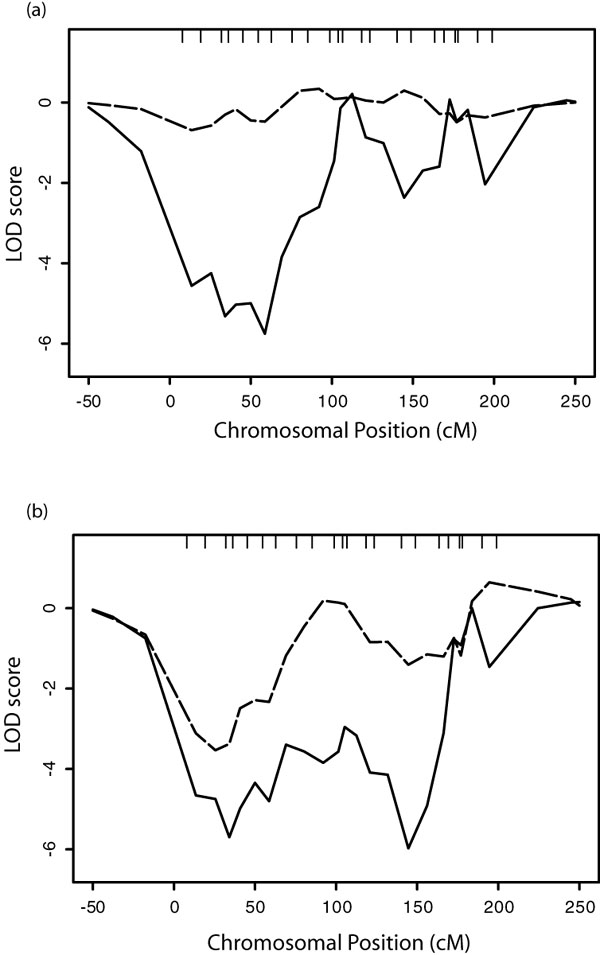
Multipoint LOD scores on chromosome 7 LOD scores on chromosome 7 for the very-high (>27.6) binary trait and the 15-category ordinal trait for (a) HDLAA and (b) HDLA. Dashed line, binary trait; solid line, ordinal trait.